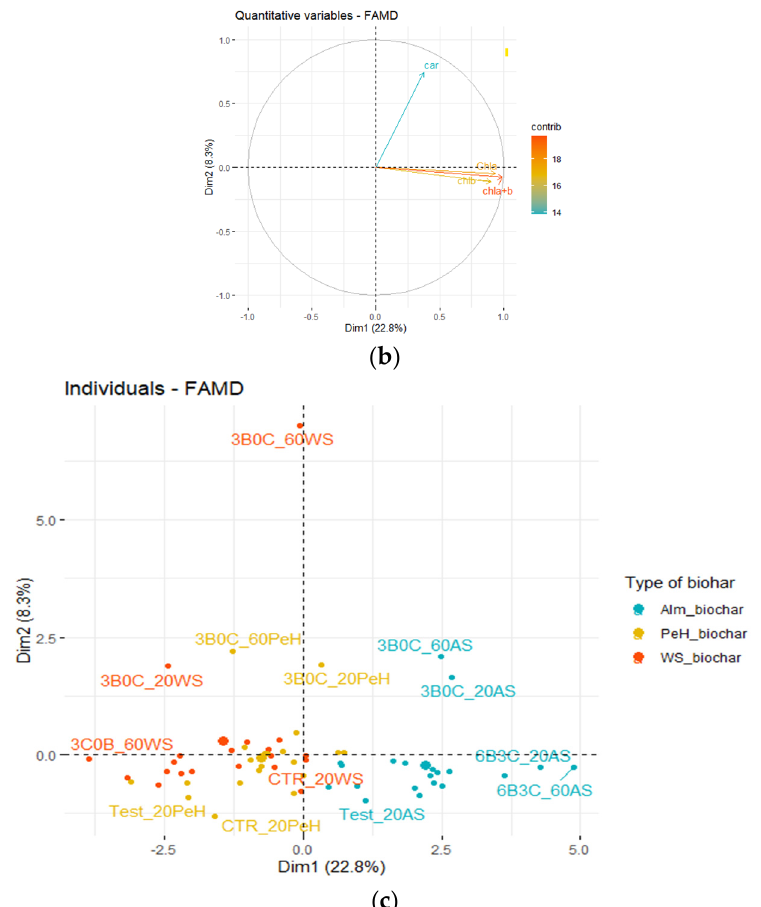
Figure 3. Physicochemical parameters of P. vaginatum FAMD during the spring season. ( a ) Under two different water conditions, four groups of P. vaginatum different factors were characterized. ( b ) The variable loading plot of the two first principal components. ( c ) The score plot describes the effect on the two first principal components for the plastic-pot treatment options when using almond shell biochar, walnut shell biochar, and peanut hull biochar.